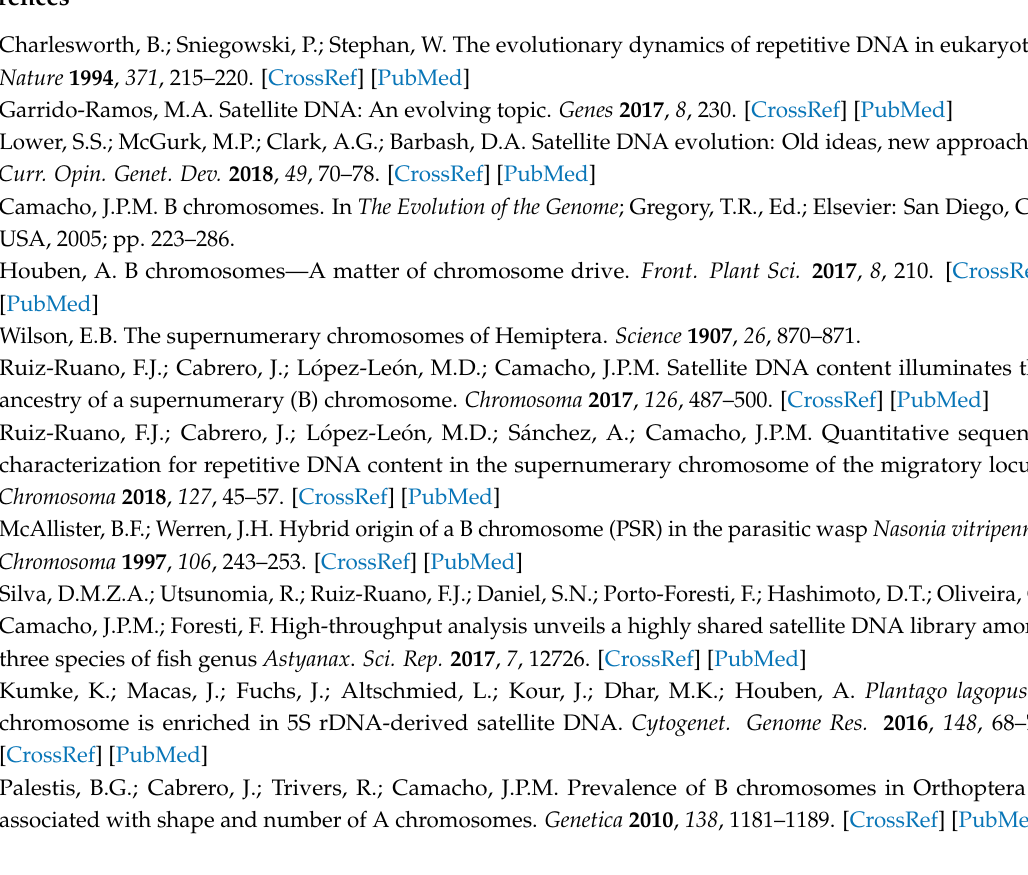
Table S1. Primers designed in this work and used for PCR amplification of satellite DNAs in the three species of